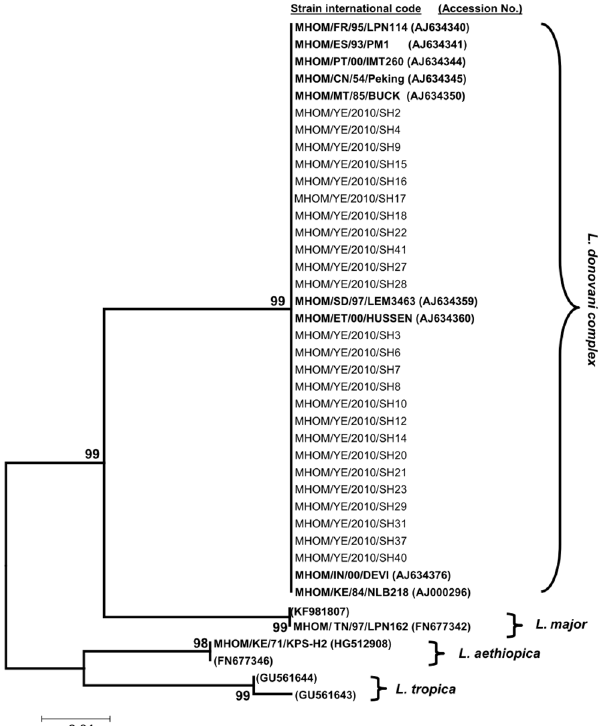
Fig 1. Phylogenetic study of L . donovani complex causing VL among Yemeni children. Unrooted NJ phylogenetic tree showing the relationships of 25 ITS1 sequences of Leishmania species isolates from Yemeni children with VL and sequences representing L . infantum , L . donovani , L . major , L . tropica and L . aethiopica . Bold-type represents reference sequences from GenBank. Abbreviations of countries of origib: FR, France; ES, Spain; PT, Portugal; CN, China; MT, Malta; SD, Sudan; ET, Ethiopia; KE, Kenya; IN, India; TN, Tunisia, YE,